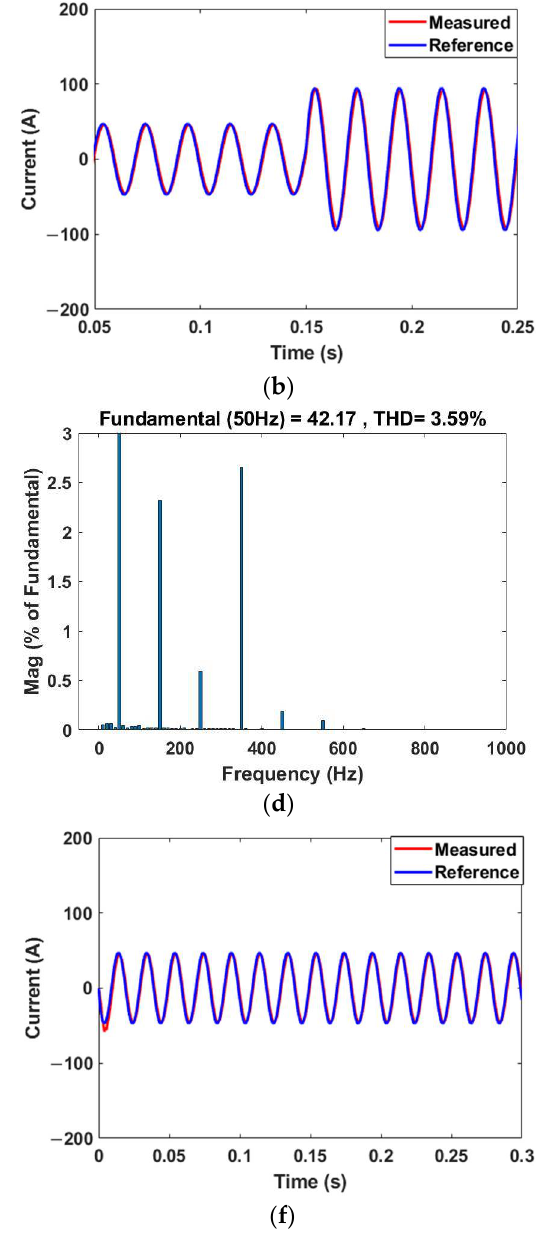
Figure 7. Output current I 2 using the SMC controller: ( a ) under NGO; ( b ) during step response at 0.15 s; ( c ) under AGO; ( d ) THD of AGO response; ( e ) during voltage sag and ( f ) voltage swell in grid voltage.